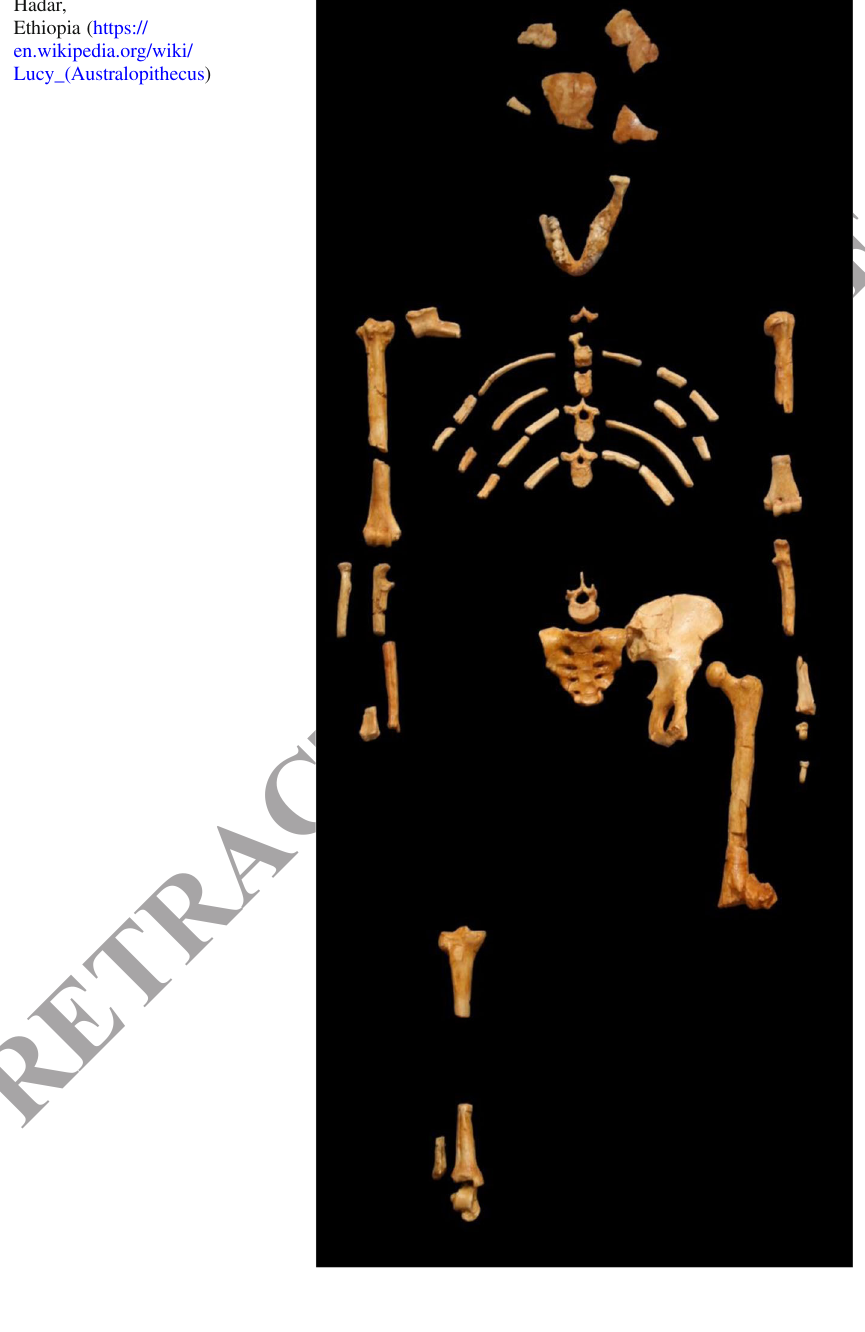
Fig. 1 A. Afarensis , Lucy from Hadar, Ethiopia (https://